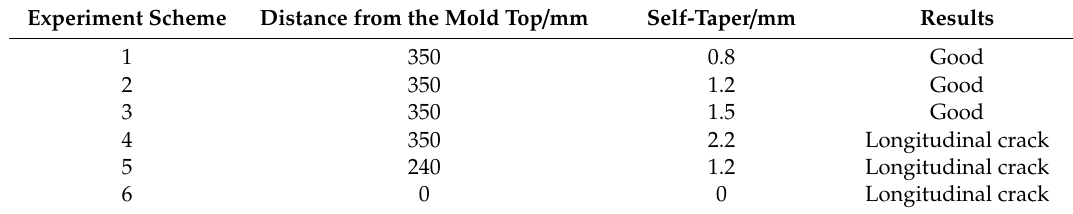
Table 5. Test results of di ff erent molds.